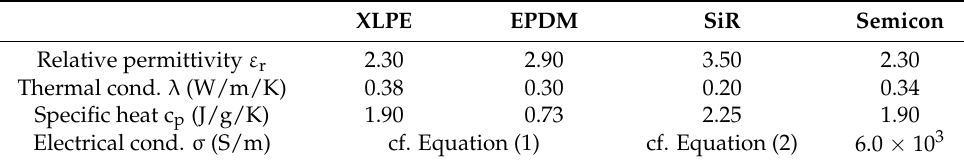
Table 2. Material parameters used in the model.